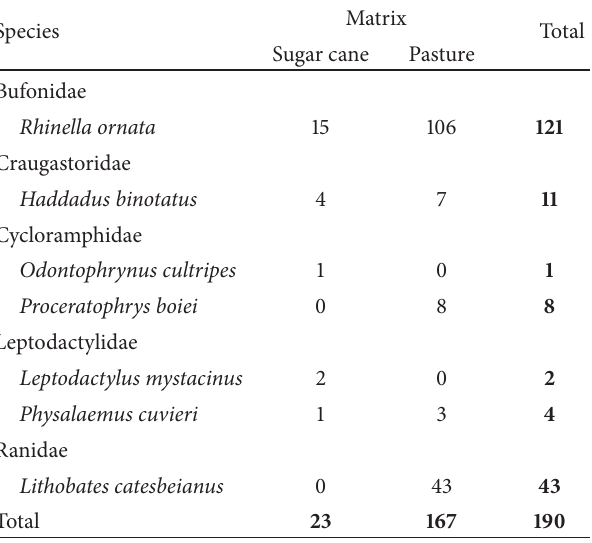
Table 1: List of terrestrial amphibian species and their abundance in fragments of Semi-deciduous seasonal forest with two predominant matrix types (sugar cane and pastures).